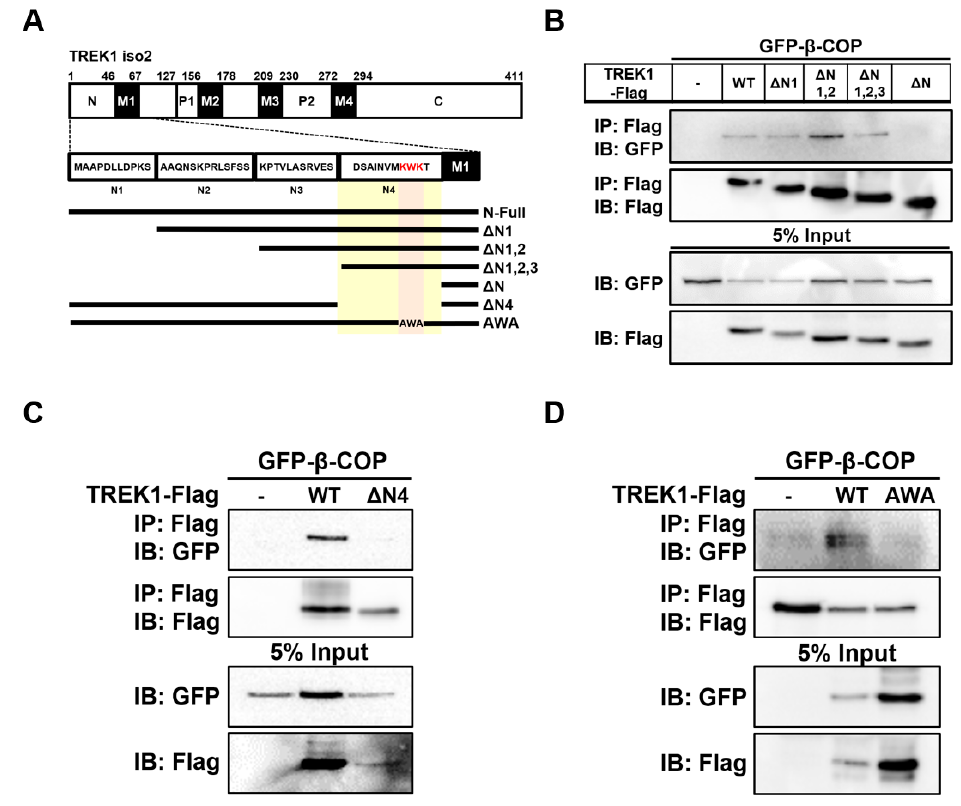
Figure 3. Identification of TREK1 binding site with β -COP. ( A ) Schematic of full-length TREK1 and its N-terminus deletion mutants. ( B ) Co-IP assay in HET293T cell. After transfection of the Flag-tagged TREK1 ∆ 1, TREK1 ∆ 1-2, TREK1 ∆ 1-3, TREK1 ∆ N4, and GFP- β -COP, immunoprecipitation with the Flag was performed, and blotted with GFP. ( C ) Co-IP assay in HET293T cell. After transfection of the Flag-tagged TREK1WT, TREK1 ∆ N4, and GFP- β -COP, immunoprecipitation with the Flag was performed and blotted with GFP. Co-IP assay shows β -COP does not interact with only TREK1 ∆ N4 deletion mutation. ( D ) After transfection of the Flag-tagged TREK1 or TREK1 AWA and GFP- β -COP, immunoprecipitation with the Flag was performed and blotted with GFP.